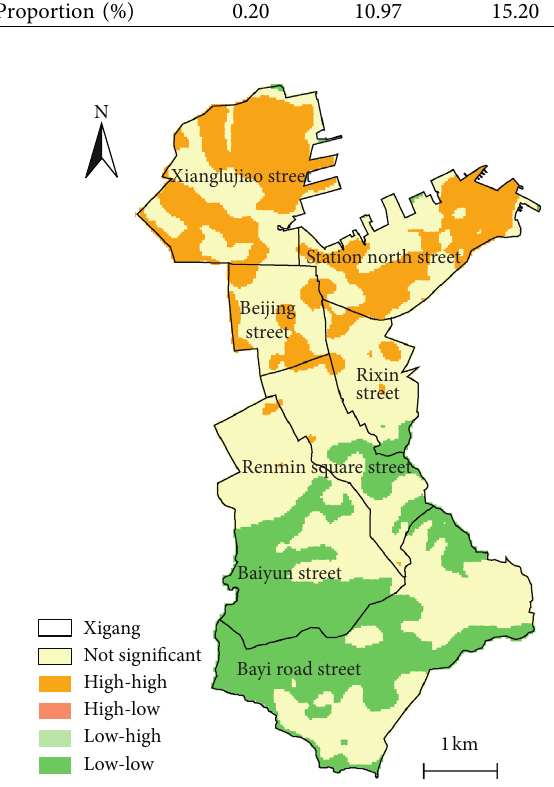
Figure 3: Local spatial Table 4: OLS model regression results.